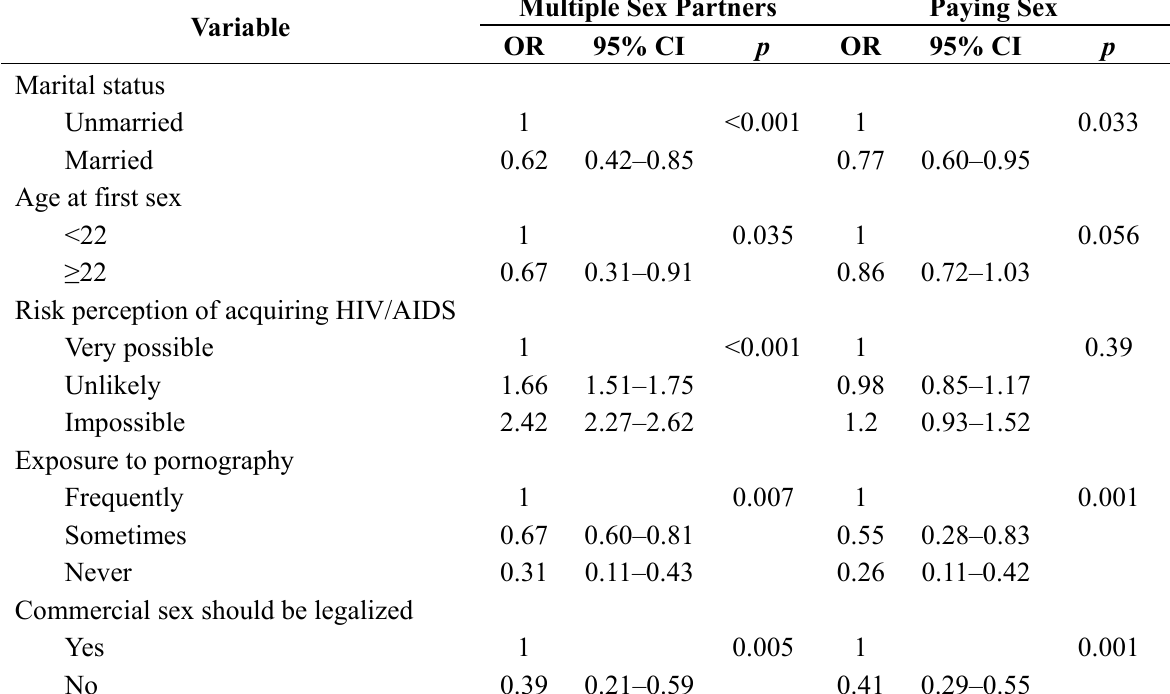
Table 7. Logistic regression analysis of factors correlated with ever having risk sexual